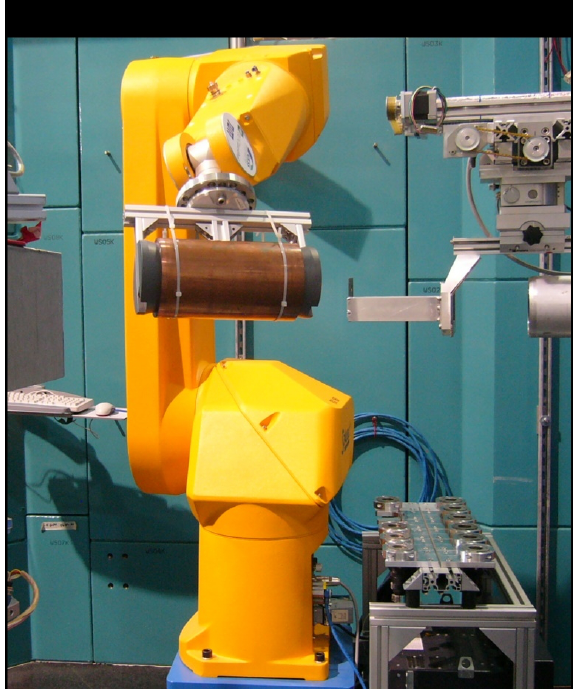
Figure 2: Robot at STRESS-SPEC holding a copper tube for combined texture and strain